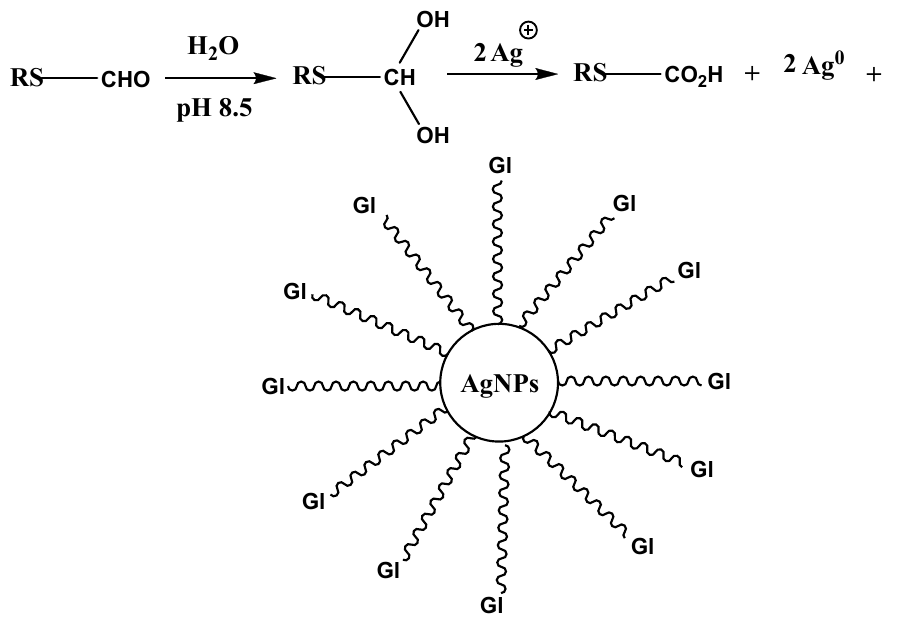
Figure 4. Effect of PH on the color evolution of the gelatin-silver reagent. Conditions: A 1 mL of the reaction mixture contained 250 µL maltose (0.1 mM), 250 µL Tris–HNO 3 buffer with deferent PH (0.2 M), 500 µL gelatin-silver reagent (1:3), incubated for 10 min at 90 °C, cooling read absorbance at 434 nm. Each point represents the mean of three experiments ± SE.